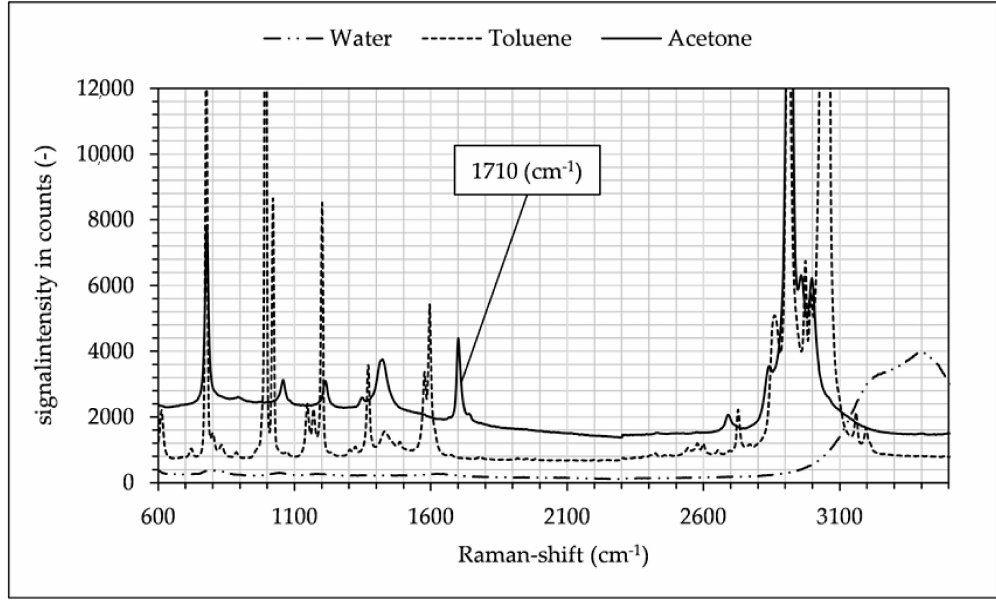
Figure 5. Raman spectra of toluene, acetone and water recorded with RXN1 spectrometer (Kaiser Optical Systems). The acetone peak at 1710 cm − 1 used for concentration determination is framed. Spectra are offset by 500 and 1000 counts.